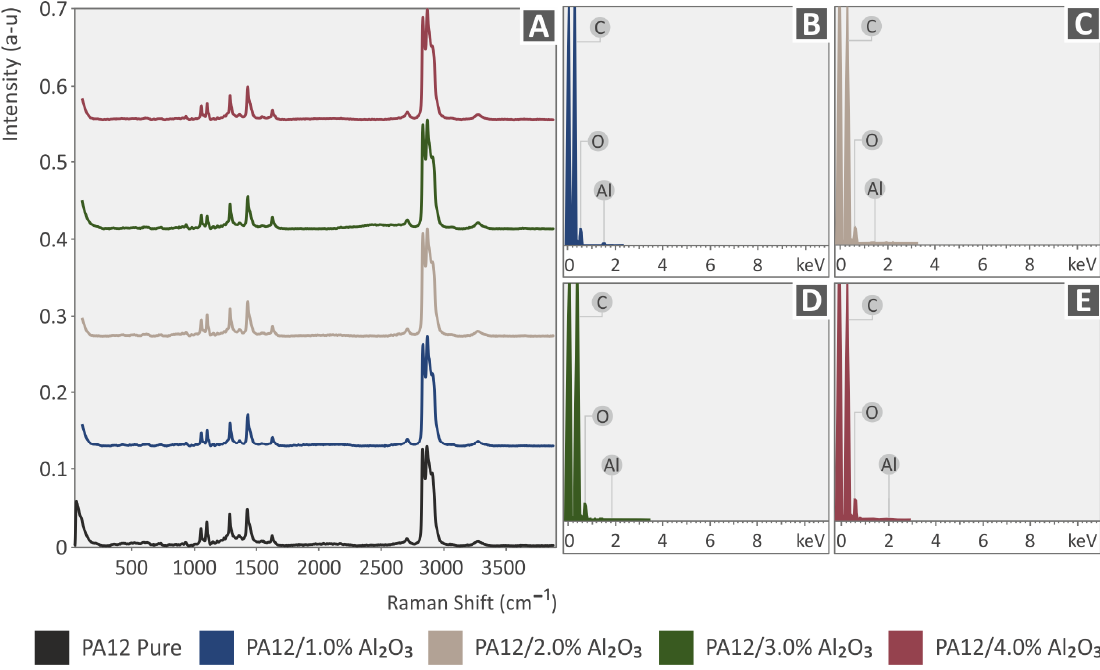
Figure 3. ( A ) Raman spectra for neat PA12, PA12 with 1.0 wt.% Al 2 O 3 , PA12 with 2.0 wt.% Al 2 O 3 , PA12 with 3.0 wt.% Al 2 O 3 , and ( B – E ) EDS spectra for all 3DP PA12/Al 2 O 3 nanocomposites showing the existence of atomic Al arising from the Al 2 O 3 incorporated nanoparticles in the PA12 polymer matrix. Table 1. Major Raman peaks identified and their related assignments.